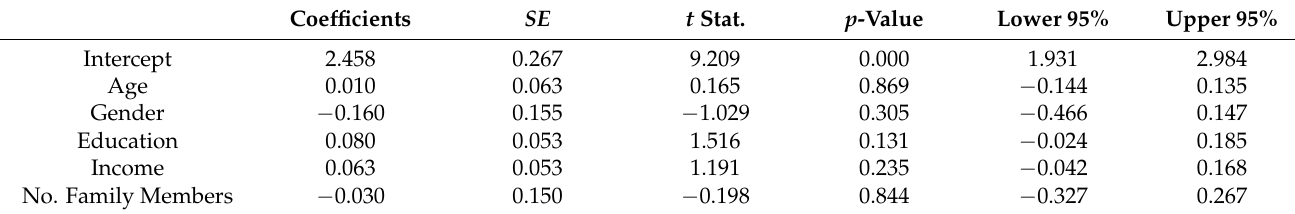
Table 6. Ordinal regression for positive communication.